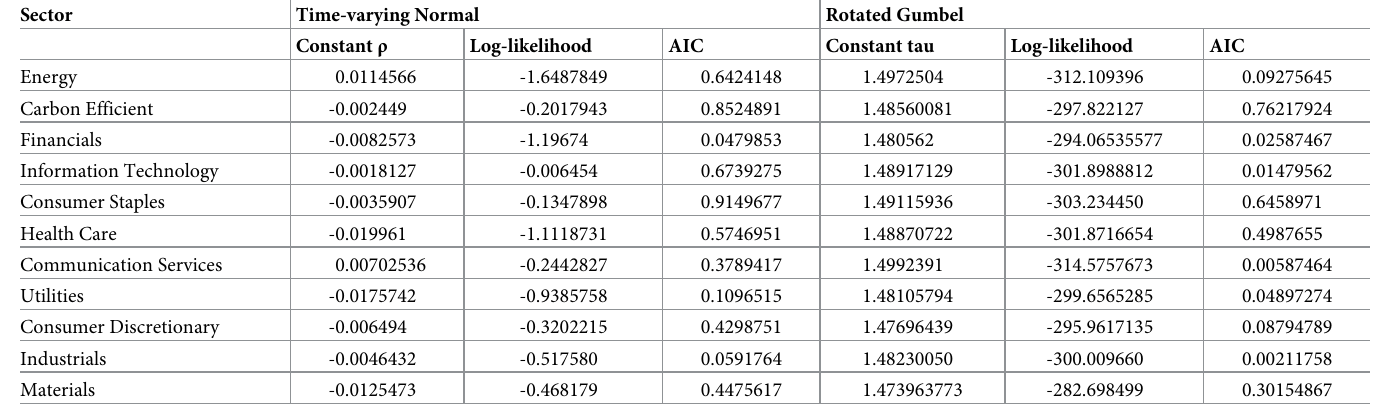
Table 3. Time-varying copula